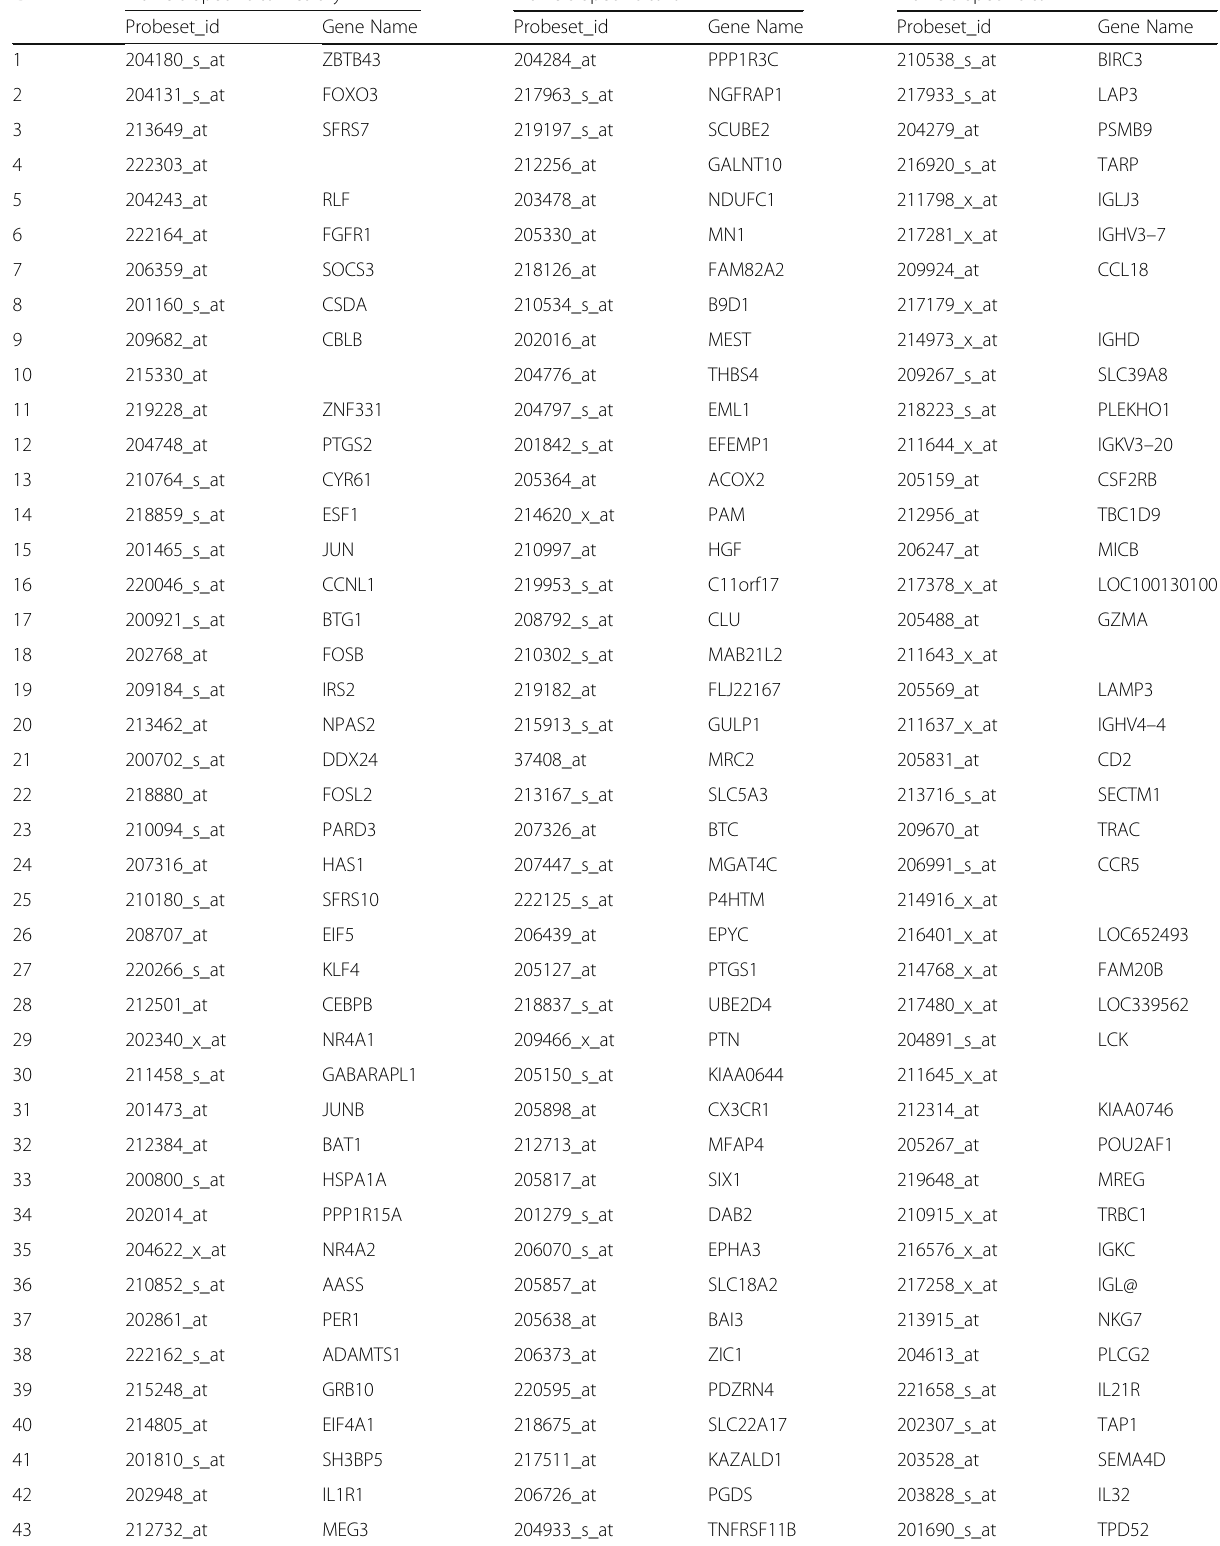
Table 1 Top Genes that are specific to healthy, OA, and RA